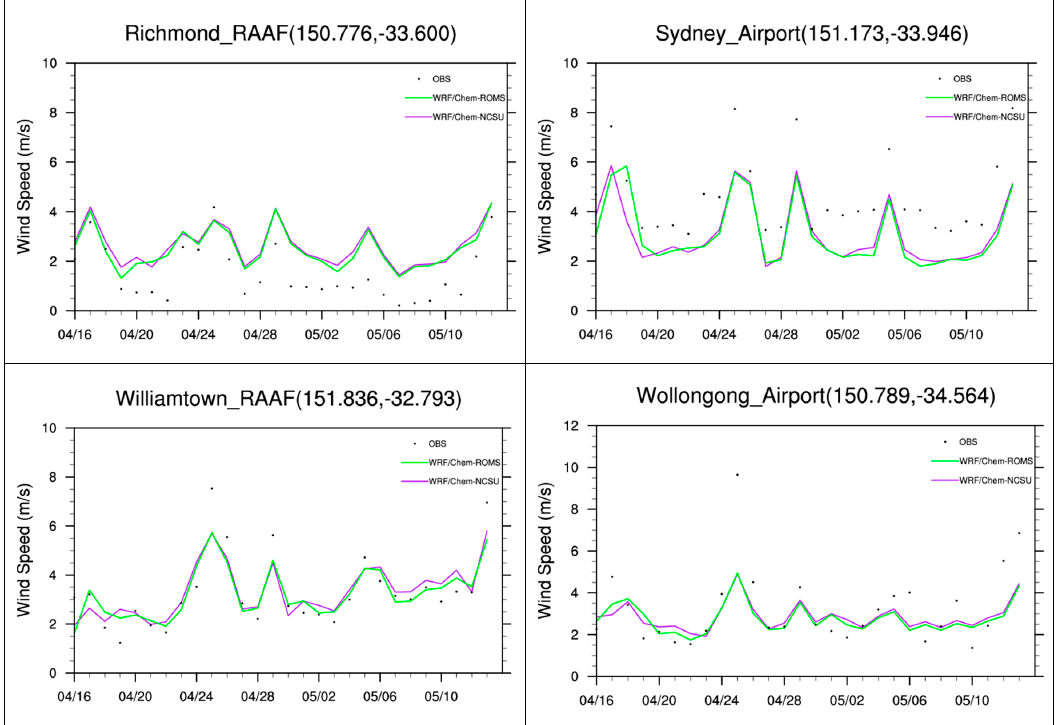
Figure 7. Observed and simulated temporal profiles of wind speed at 10 m at selected sites over the Greater Sydney at 3 km (d04) during SPS2. Two sets of simulation results at 3 km are compared, one from WRF/Chem-NCSU and one from WRF/Chem-ROMS.